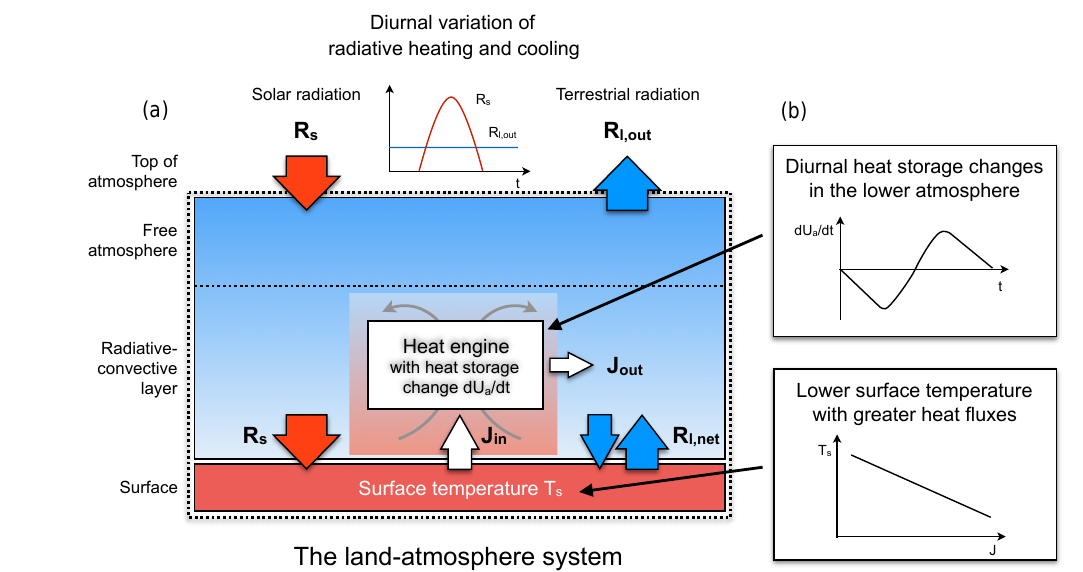
Figure 1. Schematic diagram of the land–atmosphere system where turbulent heat fluxes from the surface, J in , act as the driver of an atmospheric heat engine that generates convective motion and which sustains the heat fluxes. The heat source of the engine is the absorption of solar radiation at the surface, R s , reduced by the net exchange of terrestrial radiation, R l , net , which depends on surface temperature. The two critical effects that set the limit on how much work the engine can perform are illustrated in panel (b) : diurnal changes in heat storage in the lower atmosphere due to the diurnal variation of solar radiation and the reduction in surface temperature, T s , due to greater turbulent heat fluxes both lower the work output of the